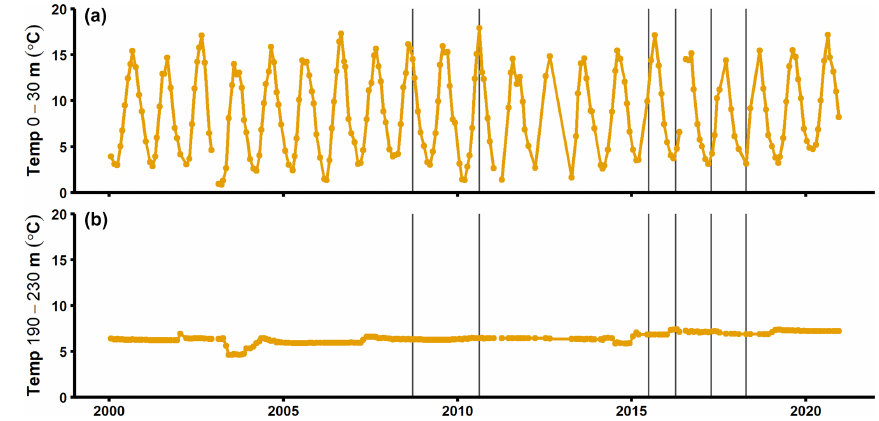
Figure A7. Temperature in the surface layer (a) and deep layer (b) at the SMHI station BY15 (SMHI, 2021). The grey lines indicate when samplings for this study were conducted (2008, 2010: August/September; 2015: early July; 2016–2018: April).